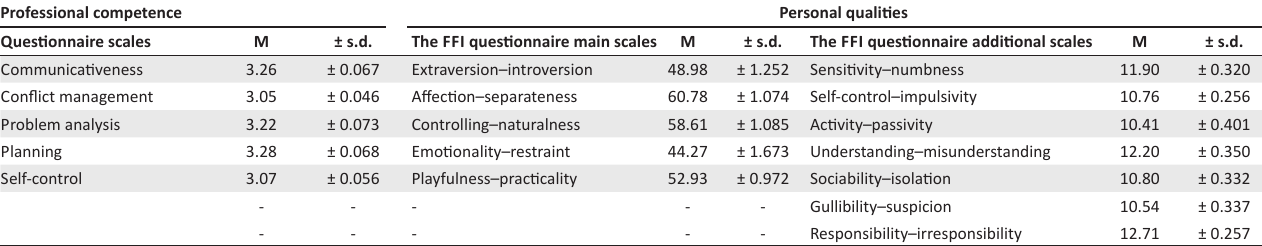
TABLE 5: Average values of mediators’ professional competencies and personality traits important for the job. Professional